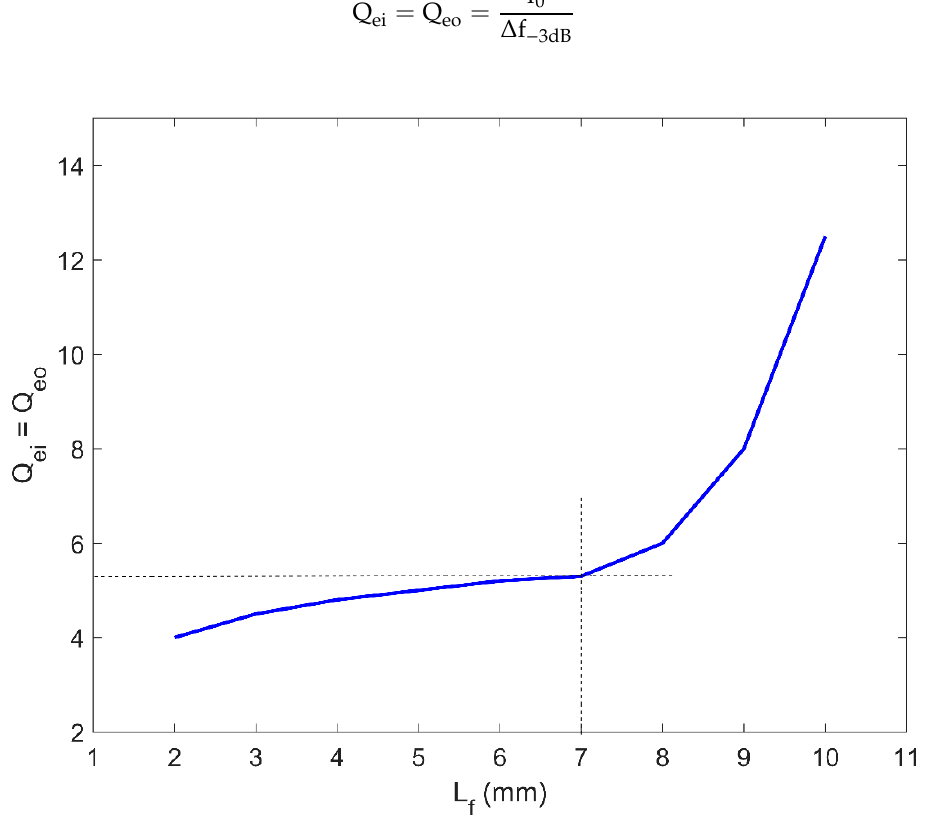
Figure 3. Theoretically calculated input / output external quality factor of the presented three-pole planar BPF.